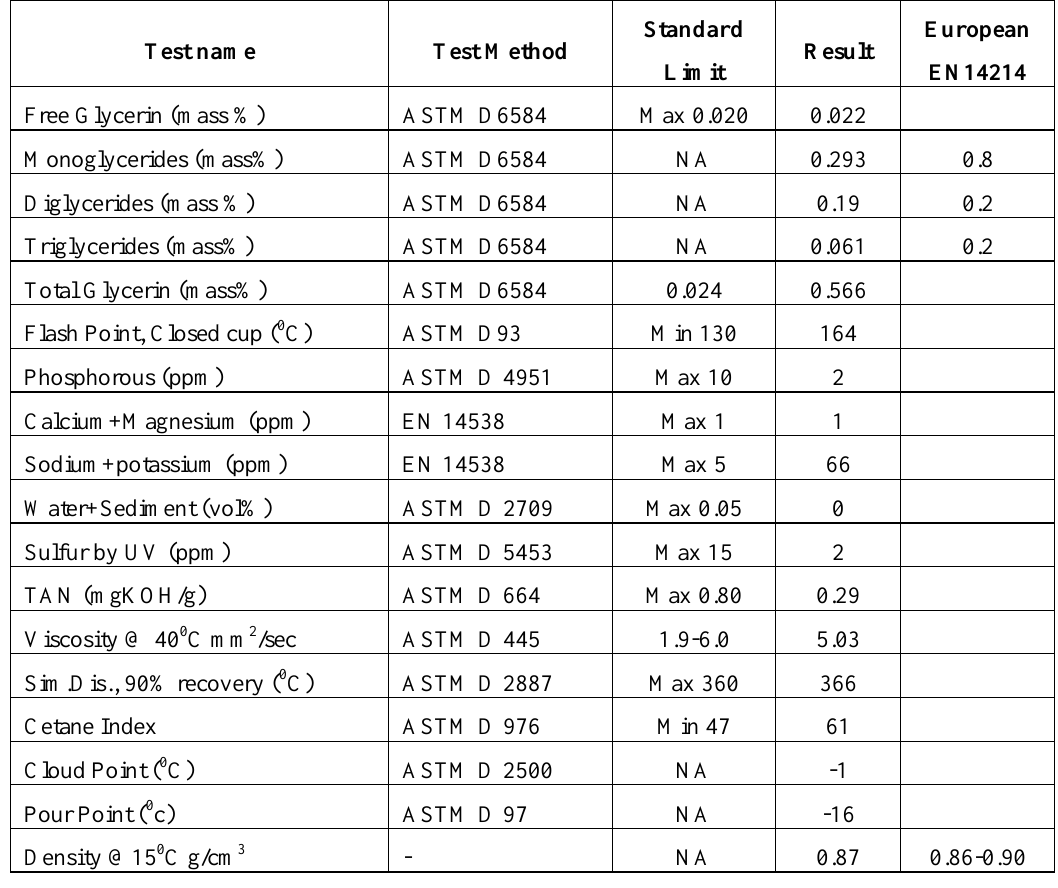
Table 3. Fuel Properties of Waste Cooking Oil